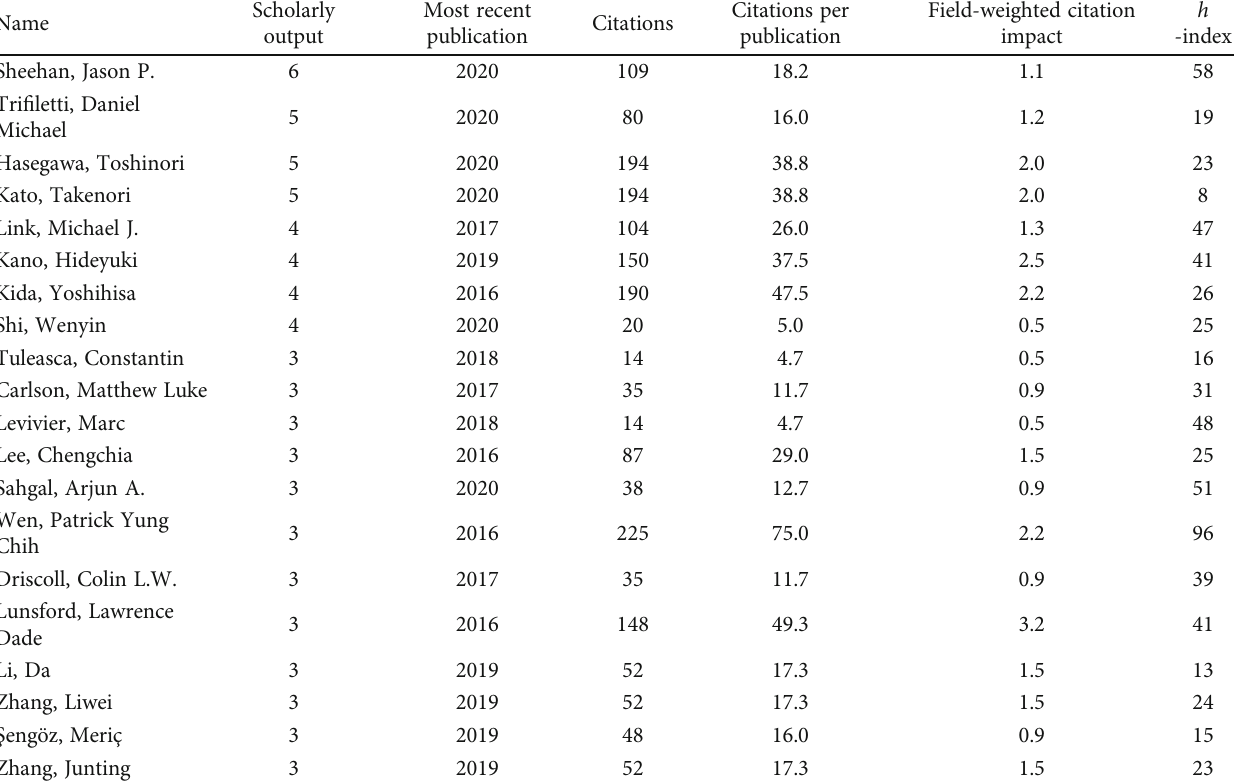
Table 6: Top 20 authors, by scholarly output in Scopus of all publication types about knife